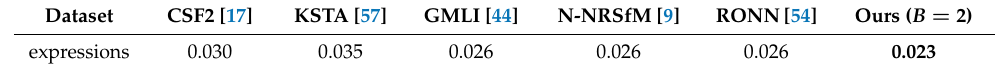
Table 6. e 3 D on the expressions dataset.